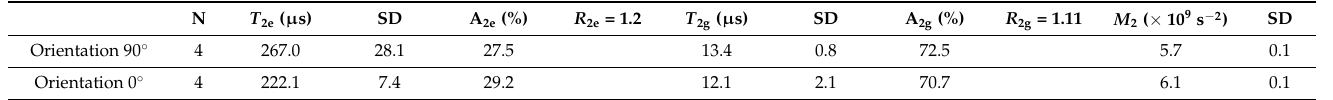
Figure 7. The NMR signals measured (HL = 0.084, orientation 90°) in solid echo experiments on untreated silk fibres B.mori (black triangles) and silk fibres B.mori after tensile loading (89 g) in water environment (blue circles). The data were normalised per maximum signal in each experiment on these samples. Amplitude (A) of signal (Y-axis) is presented in log-scale (arb.units). Small inset shows initial parts of the decays to better differentiate fast relaxing components. Table 4. T 2 data on the silk fibres B.mori samples (at HL = 0.084) measured at 0° and 90° orientation. T 2 values are presented as means for N experiments with standard deviation (SD). R 2e = T 2e90 / T 2e0 is degree of anisotropy based on slow-relaxing T 2 component (water protons), and R 2g = T 2g90 / T 2g0 is degree of anisotropy calculated with fast-relaxing T 2 component (solid protons) data. ( L 1 – L 2 )/ L 1 = 1.7–2.4%.